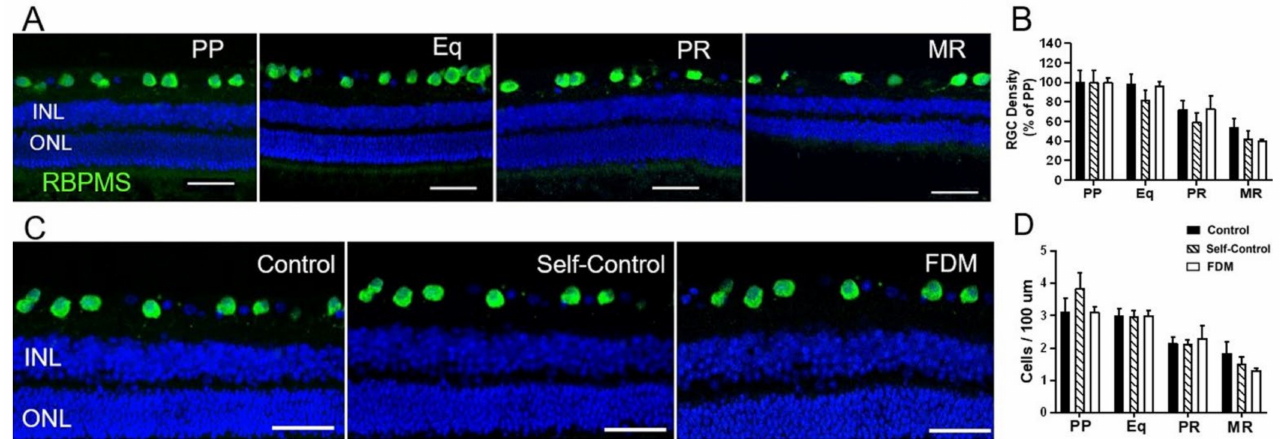
Figure 6. Retinal ganglion cells (RGC) in different groups of retinas. ( A ) Representative confocal images taken from the posterior pole (PP), equator (Eq), peripheral retina (PR) and marginal retina (MR) of naïve-control eye staining for RBPMS. Nuclei were stained with DAPI (blue). ( B ) The density of RGC expressed as % of PP in different retinal locations in naïve control, self-control and FDM eyes. PP of naïve control, self-control and FDM eyes. Nuclei were stained with DAPI (blue). ( C ) Representative confocal images taken from the PP of naïve control, self-control and FDM eyes showing RBPMS + RGC. Nuclei were stained with DAPI (blue). ( D ) Quantitative data showing the number of RGCs in different retinal locations of the three groups of guinea pigs. Scale Bar: 50 µ m. Mean ± SD, n = 3~9/group.